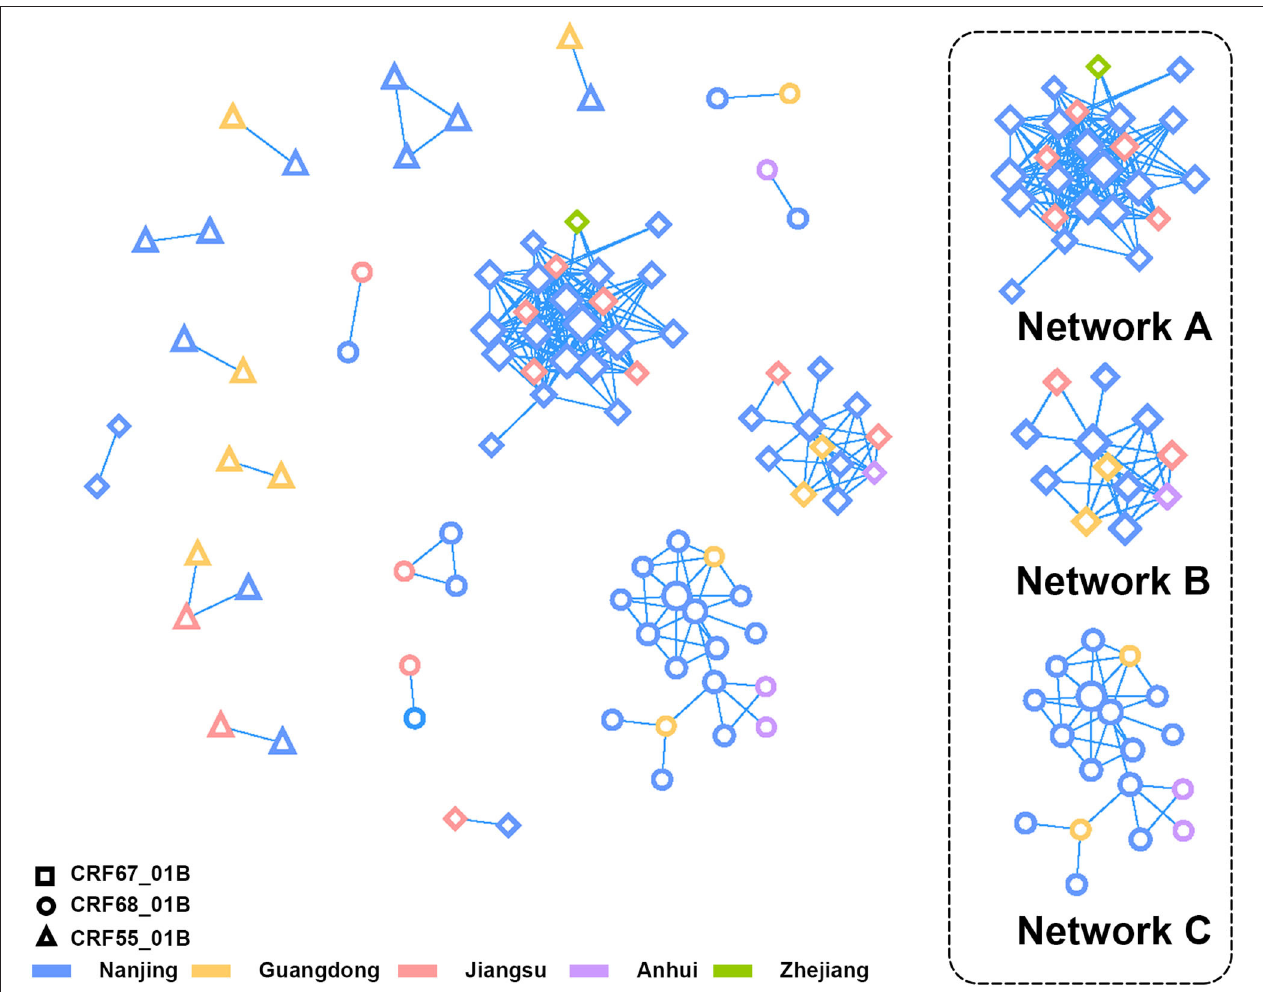
FIGURE 3 | The transmission network analysis of CRF01_AE/B recombinants in Nanjing. The different shapes and colors of nodes represented different CRF01_AE/B recombinants and the district of Pol sequences profiles, respectively. The three lager clusters on the right side were composed of CRF67_01B (Network A and B) and CRF68_01B (Network